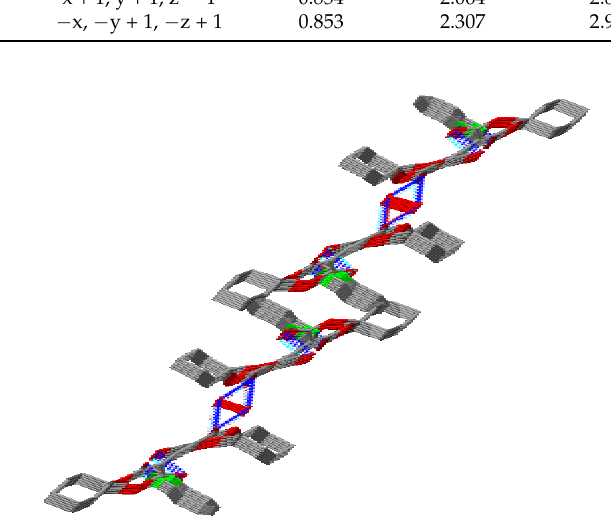
Figure 3. One-dimensional ( 1D)-chained structure by N–H···O and O–H···O intermolecular interactions.